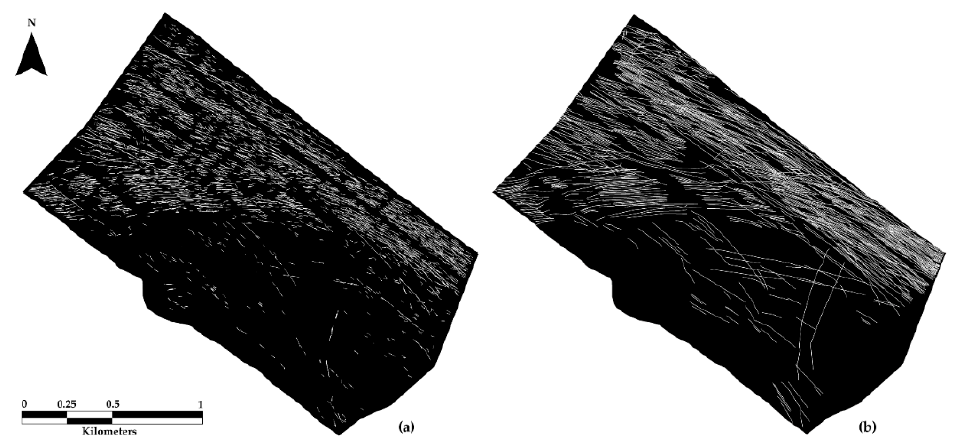
Figure 11. ( a ) A binary image showing the automatically extracted TMs and ( b ) an image depicting the manually digitized TMs (dataset from [24]).